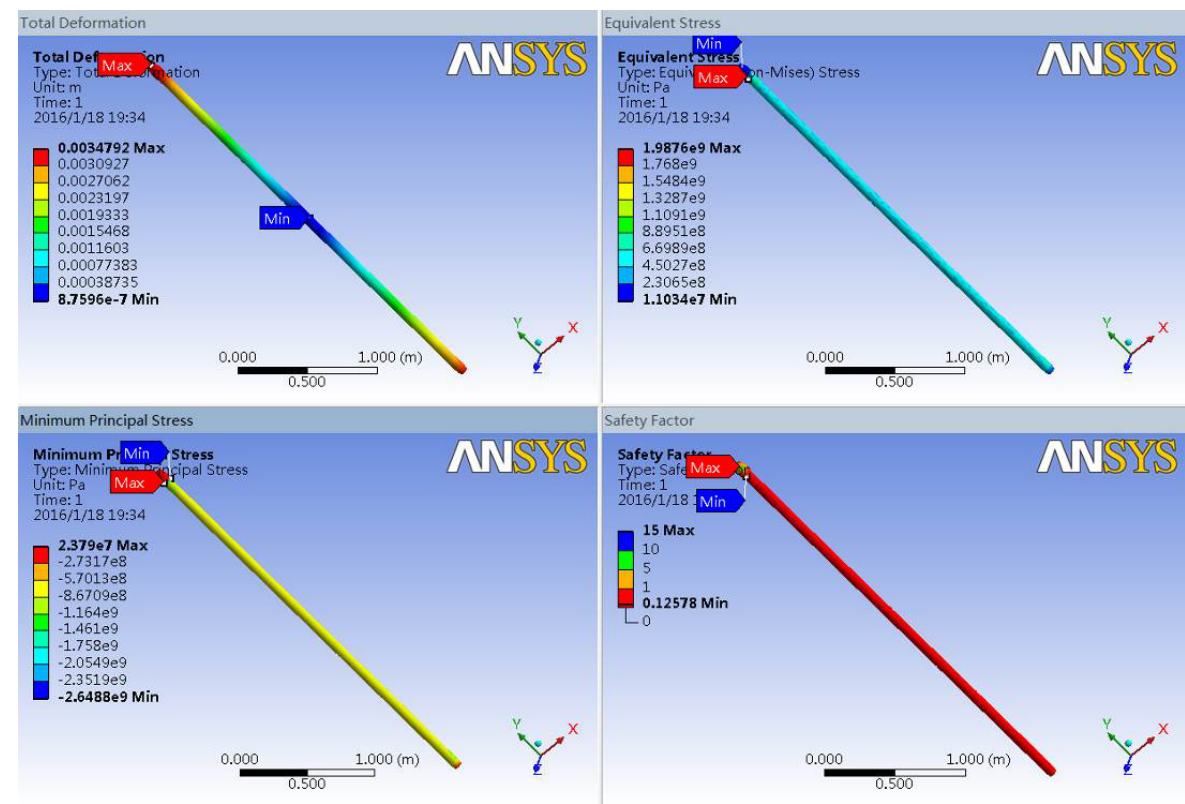
Figure 20. The stress nephogram of the coupling between the temperature field and the pressure field: the upper left is the total deformation nephogram; the upper right is the equivalent strain nephogram; the lower left is the minimum principal stress nephogram; the lower right is the Mohr–Coulomb stress displacement safety factor